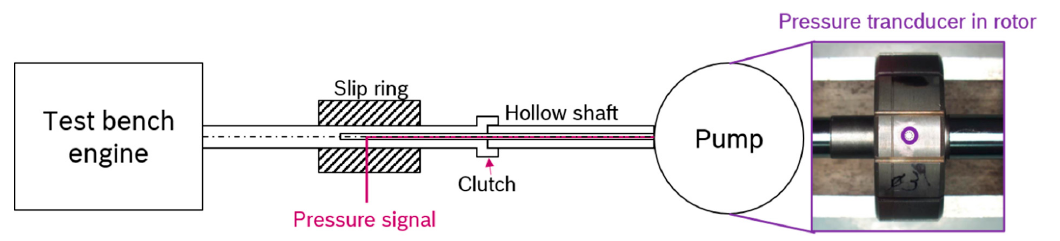
Figure 2. Schematic test bench setup.